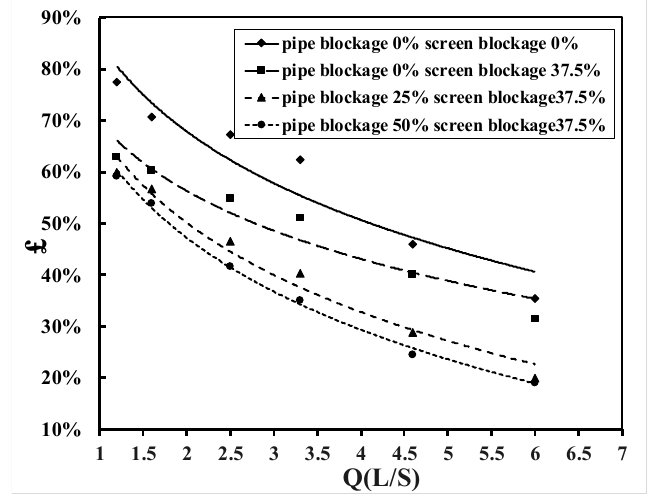
Figure 26. Relationship between £ and Q for different ratios of blockage height at surface blockage 37.5%.